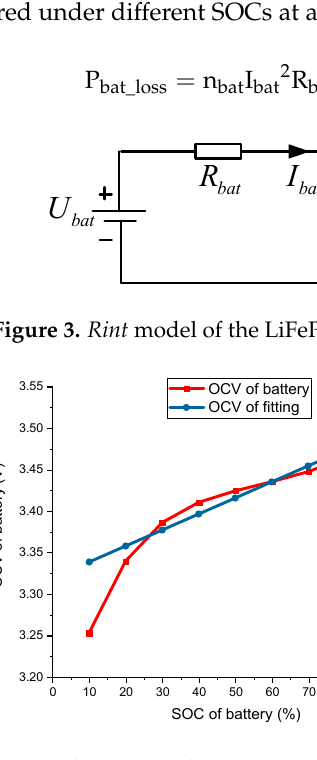
Figure 4. The relationship between V bat and SOC.